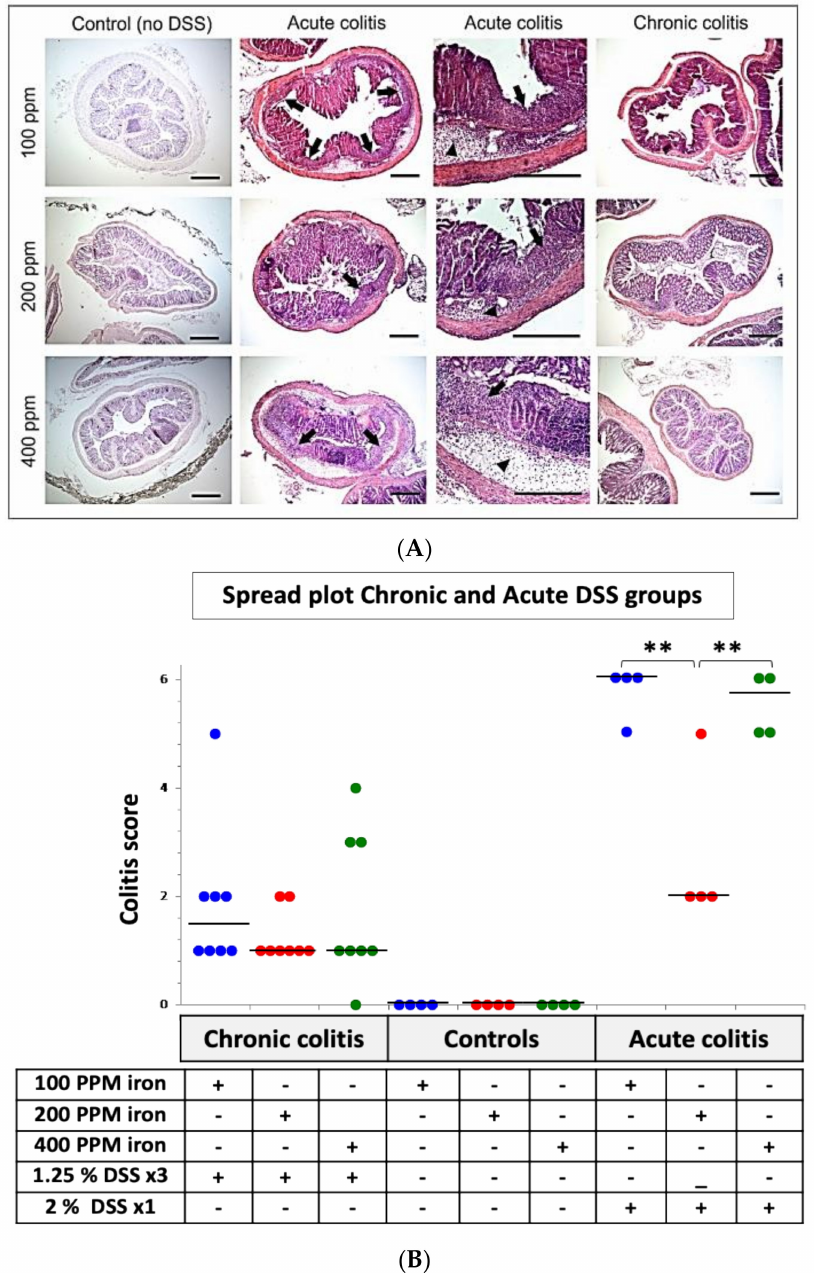
Figure 2. Histological analysis of colon from DSS-treated mice in consuming diets of differing dietary iron levels. ( A ) Representative hematoxylin and eosin-stained segments of distal colon from control C57BL/6J mice ingesting 100, 200 or 400 ppm iron diets alone ( n = 4 mice in total), C57BL/6 with acute ( n = 4) and chronic DSS-induced colitis ( n = 8) administered with 100, 200 or 400 ppm iron diets as indicated. Arrowheads highlight submucosal oedema; arrows highlight almost complete loss of colonic epithelium and leukocyte infiltration. Scale bar: 200 µ m. ( B ): Inflammation (colitis) scores for all groups’ DSS-treated (24 (63-days) and 12 (10-days) mice per group) and untreated (controls) 12 (63-days) mice on different iron diets. Horizontal lines at the median. an iron deficient diet (100 ppm iron [blue]), standard chow diet (200 ppm iron [red]) nor an iron supplemented diet (400 ppm iron [green]) Differences tested by Kruskal–Wallis test followed by multiple comparison tests ** p <